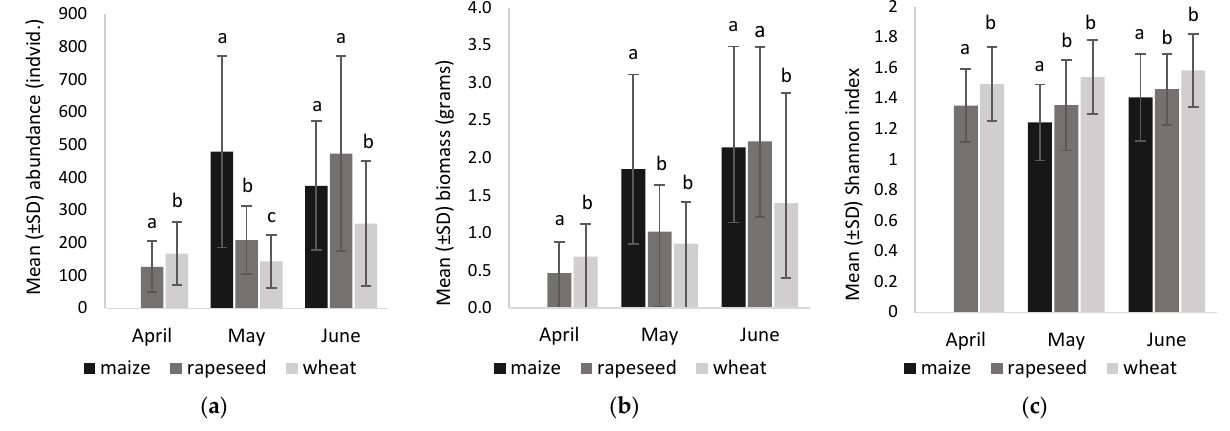
Figure 6. Comparison of ( a ) the mean abundance, ( b ) biomass and ( c ) Shannon index between crop types in individual months. Vertical lines represent the standard deviation (SD). Superscripts indicate significant differences between the crop types in each month, based on Tukey’s post ‐ hoc tests.